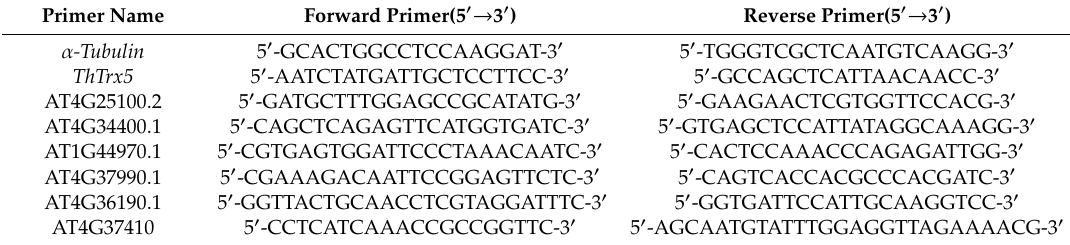
Table 3. PCR primer